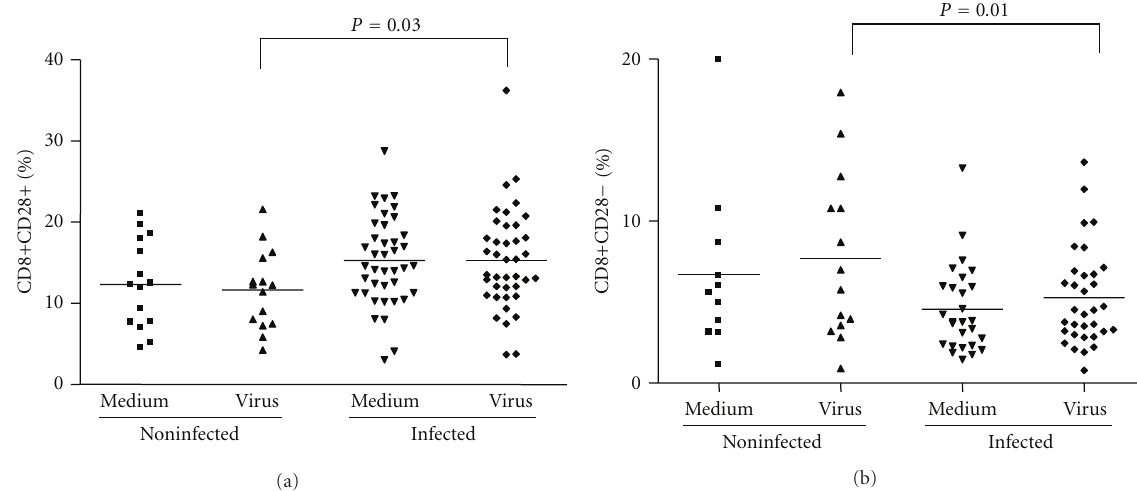
Figure 5: CD28 molecule expression and evaluation of regulatory T CD8 + cells in PBMCs from individuals infected or not by zoonotic Vaccinia virus. Peripheral blood mononuclear cells (PBMCs) from patients infected or not with zoonotic Vaccinia virus were cultured in the presence of UV-inactivated virus or mock-treated (medium). After 72 hours of stimulus, cells were labeled with mouse anti-human CD8 antibodies and anti-human CD28 antibodies. The percentages of CD8 + CD28 + (a) and CD8 + CD28 − (b) T-cell subsets were determined by flow citometry. Statistical significance ( P values), based on the median values of each group, is presented on the graphs.